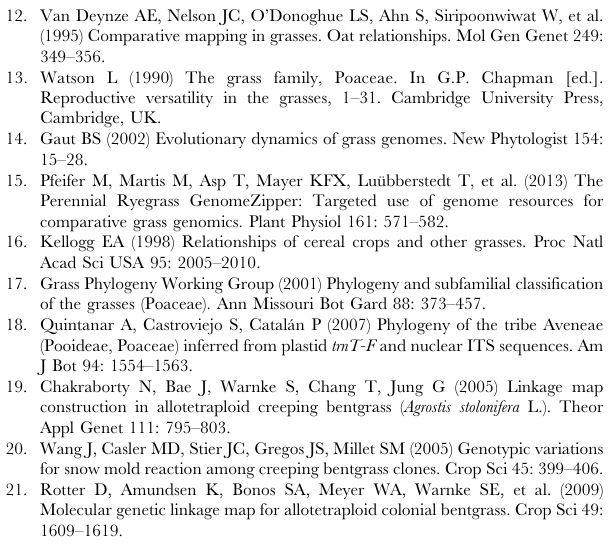
Table S2 Brachypodium distachyon chromosomal map position of sequences of EST-RFLP markers mapped on creeping bentgrass linkage map. Table S3 Creeping bentgrass ESTs orthologous to Brachypodium distachyon